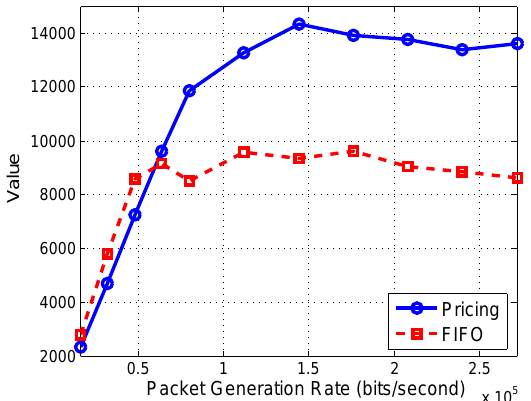
Figure 15. Comparison of value for chain